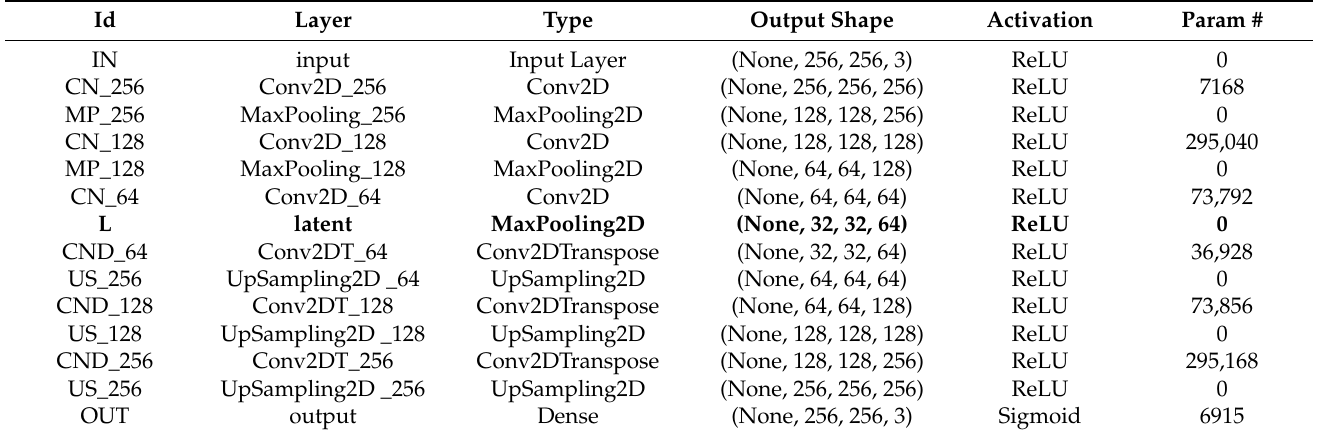
Table 3. CNN baseline training model. Bold indicates the latent layer.